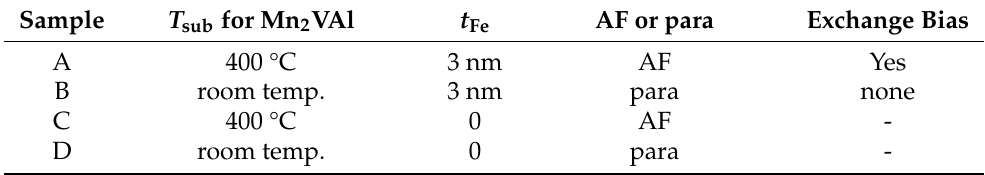
Table 1. Sample identification: The deposition temperature ( T sub ) for the Mn 2 VAl layer, Fe layer thickness ( t Fe ), and magnetic properties. AF and para represent antiferromagnetic and paramagnetic, respectively, which have been discussed in